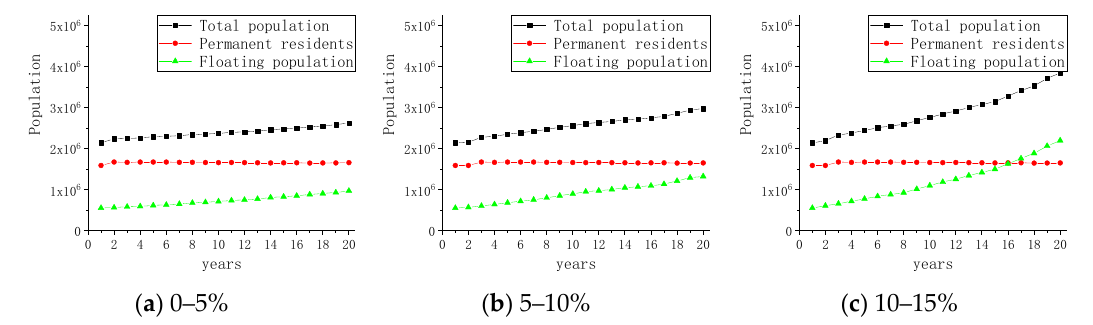
Figure 11. Population with increased growth rates of the foreign population.